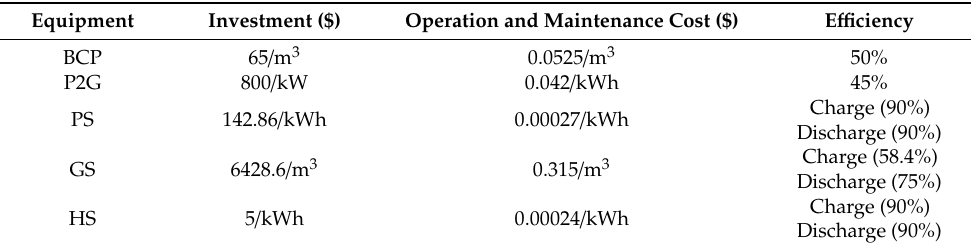
Table 2. Information of the multi-energy complementary equipment.